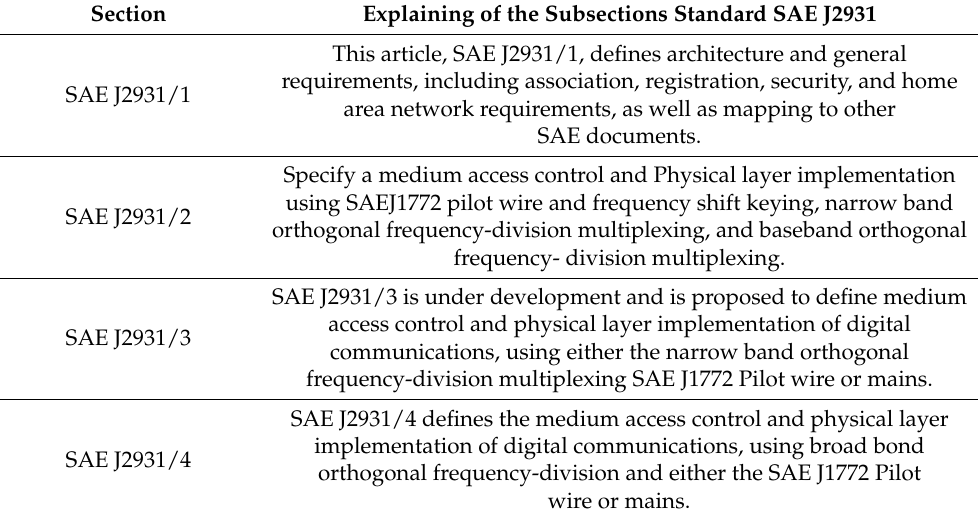
Table 3. Subsections related to the standard SAE J2931